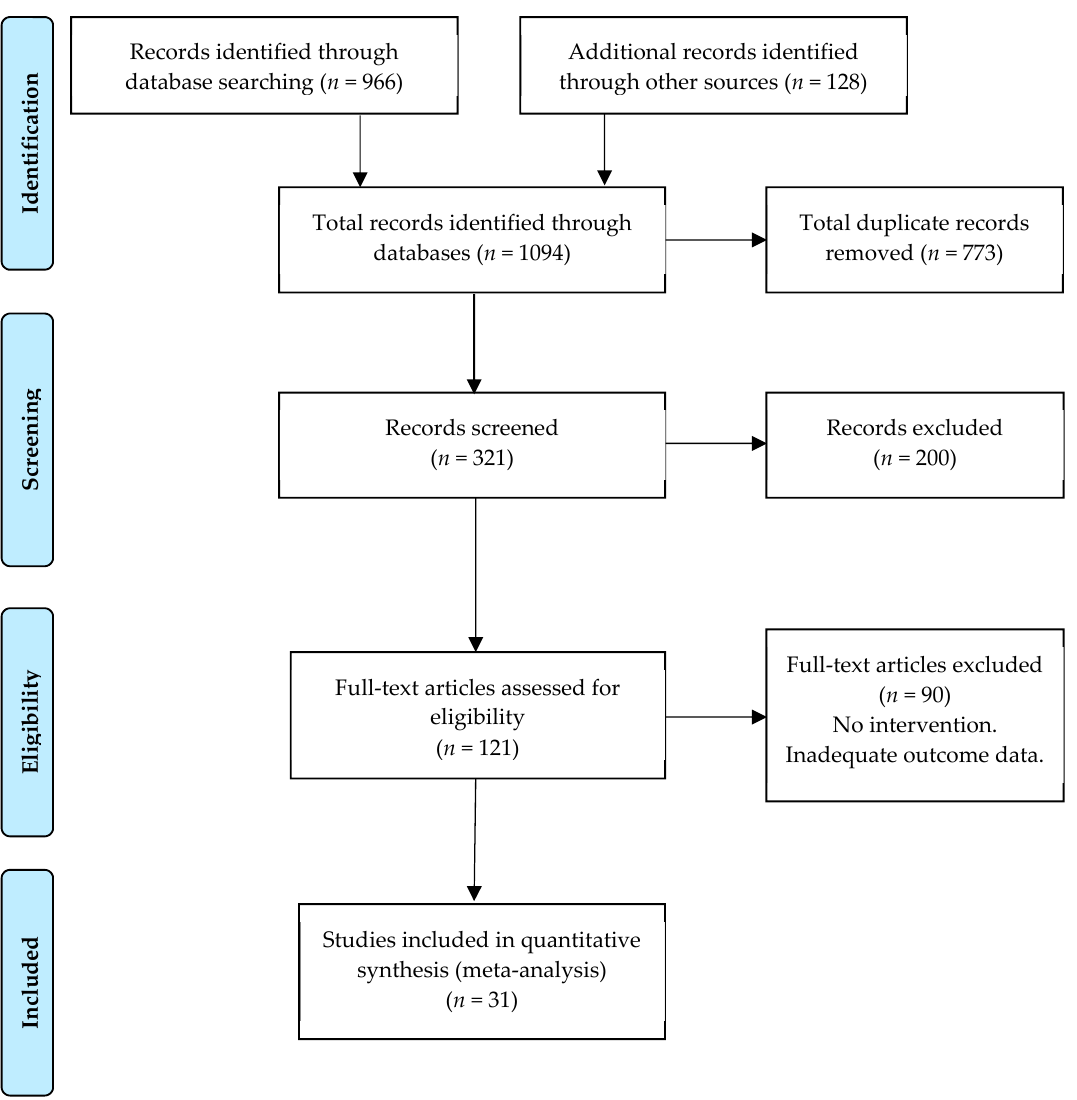
Figure 1. The PRISMA flow